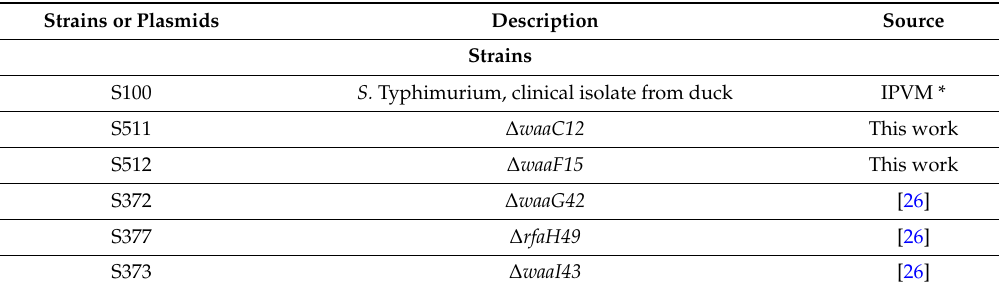
Table 2. Bacterial strains and plasmids used in this